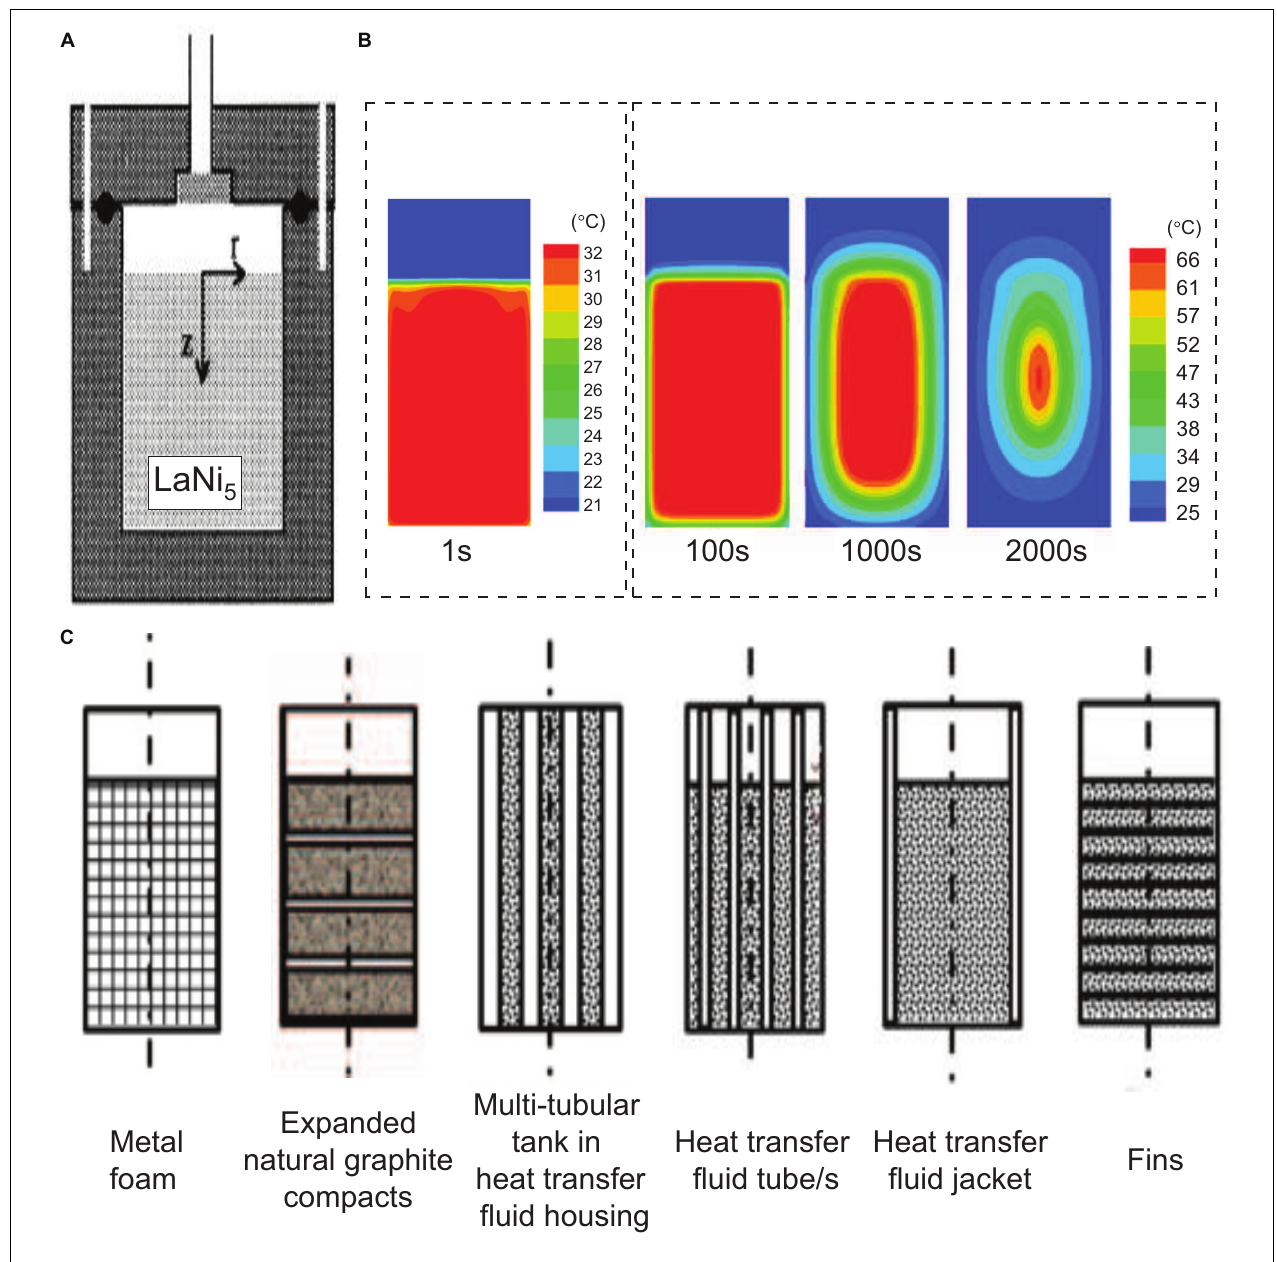
FIGURE 10 | Cross-section of the (A) tank holding LaNi 5 alloy (Jemni et al., 1999), (B) its related temperature contour upon hydrogen absorption (Wang et al., 2009) and (C) types of modified metal hydride tank designs to increase the heat transfer radially from the center of the tank (Afzal et al., 2017).